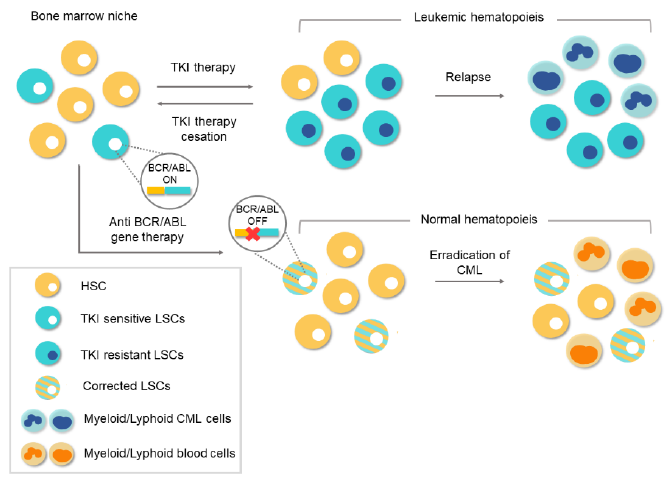
Figure 4. Conventional therapies vs. gene therapy for chronic myeloid leukemia (CML). Tyrosine-kinase inhibitor (TKI)-based conventional therapies are effective at silencing BCR/ABL1 in leukemic stem cells (LSCs). Treatment cessation can